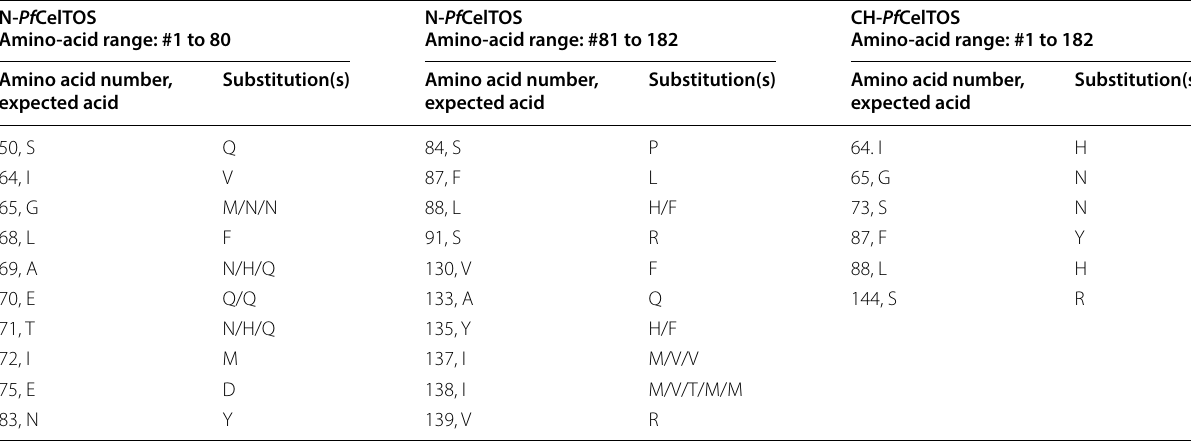
Table 1 Nonsynonymous amino acid substitutions observed by LC–MS/MS for N- Pf CelTOS and CH- Pf